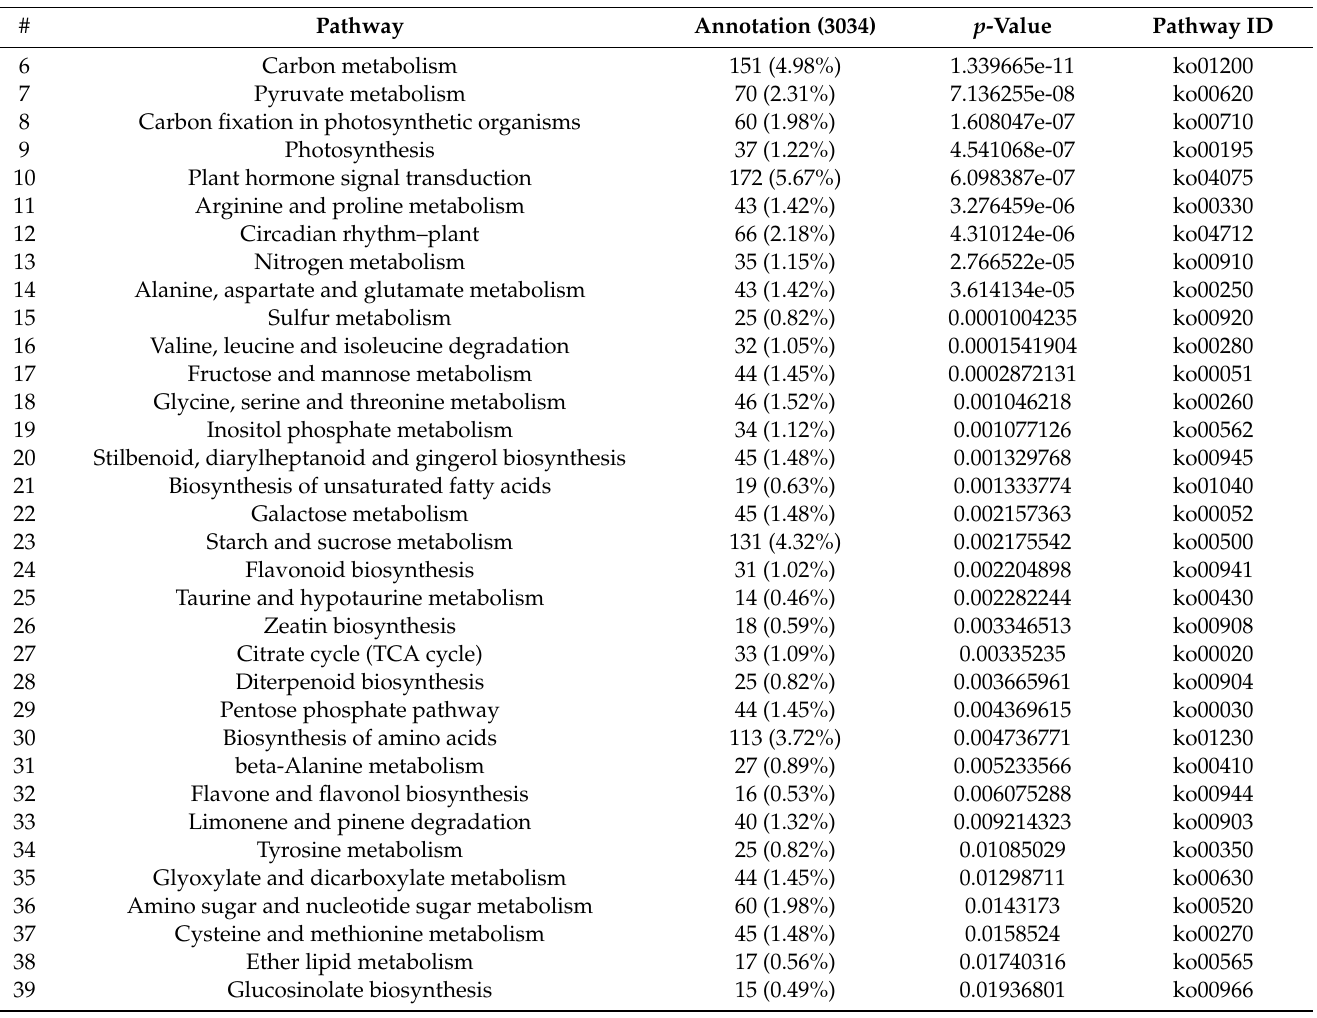
2B. KEGG pathways of DEGs in CK-R vs.